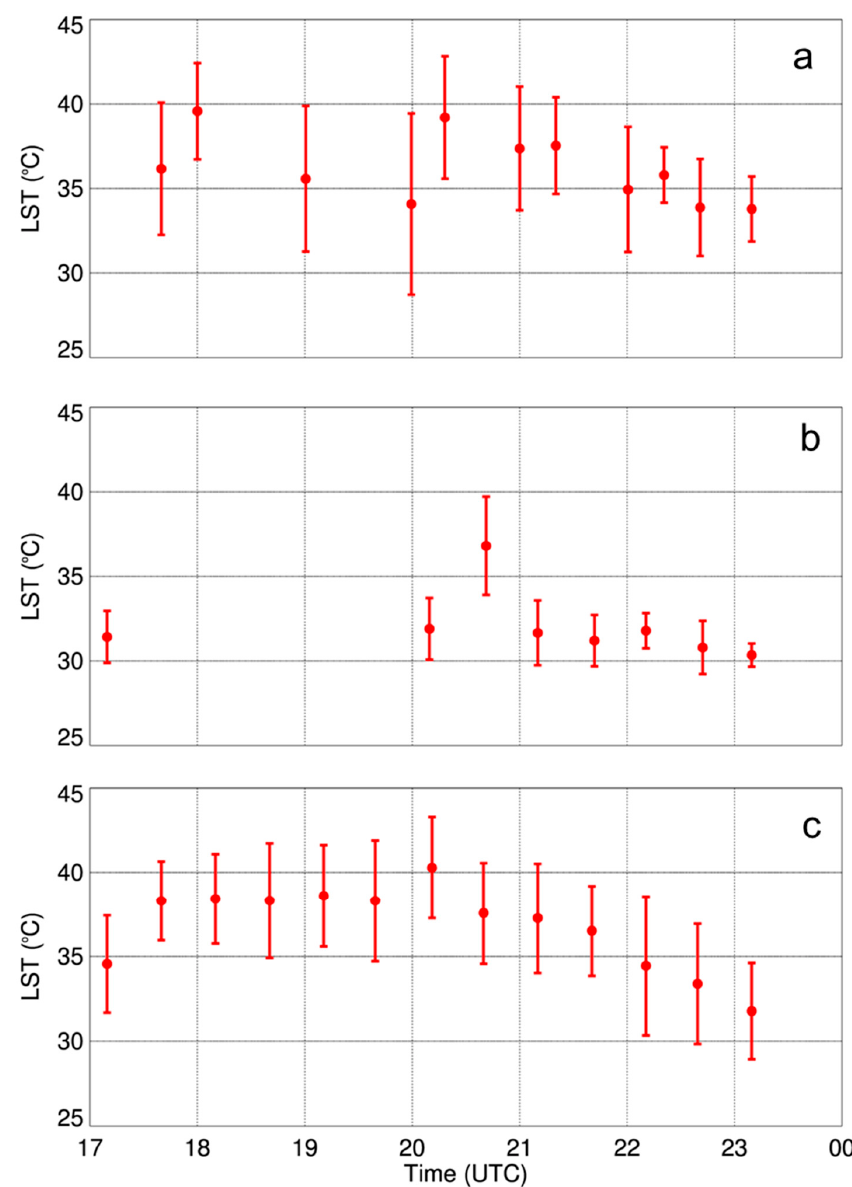
Figure 10. Mean (filled circles) ± 1 standard deviation (bars) in LST obtained from the DJI S-1000 sUAS flights on 14 August 2017 ( a ), 15 August 2017 ( b ), and 17 August 2017 ( c ) during LAFE.